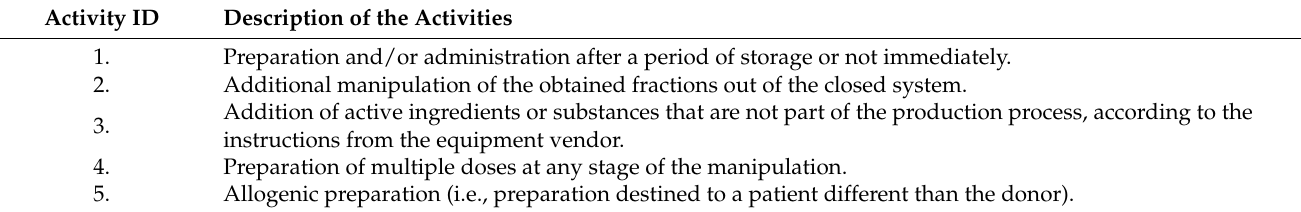
Table 2. PRP manufacturing activities allowed only with an authorization from Swissmedic (i.e.,